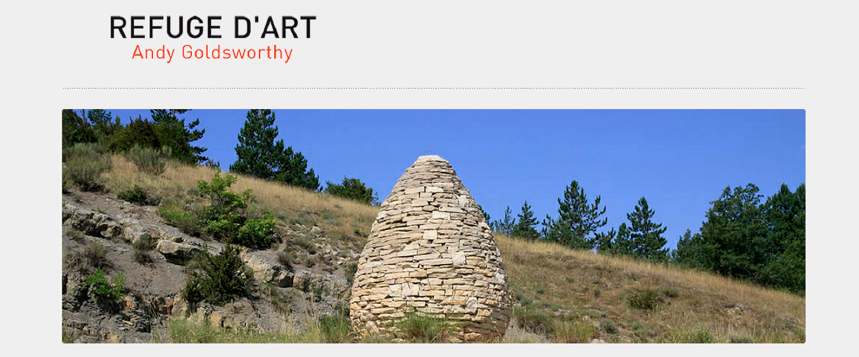
Figure 2. Andy Goldsworthy, Refuge d’art , sculpture of stones. Musée Gassendi collection, Digne-les-Bains. Source: https://www.refugedart.fr/?la=esp&rr=&ind=&his= (accessed on 30 August 2022). Courtesy of the Musée Gassendi. 35